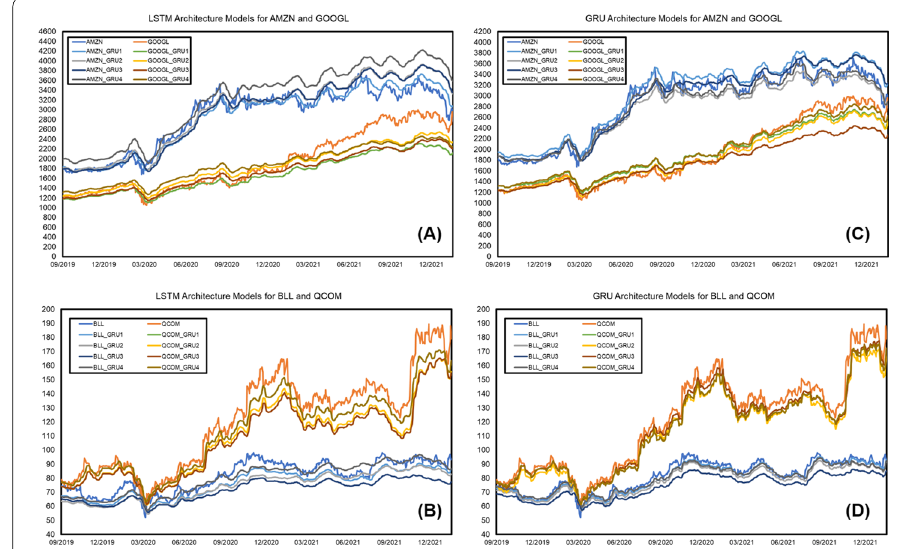
Fig. 13 Validation LSTM and GRU architectural models of four companies